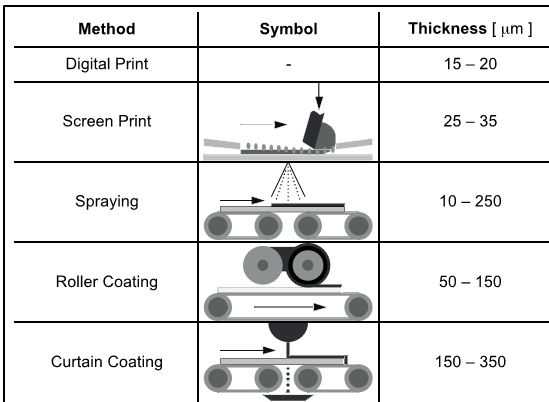
Fig. 1 Enamel-printing application processes with resulting median coating thicknesses after firing (adapted from Krampe, 2013).